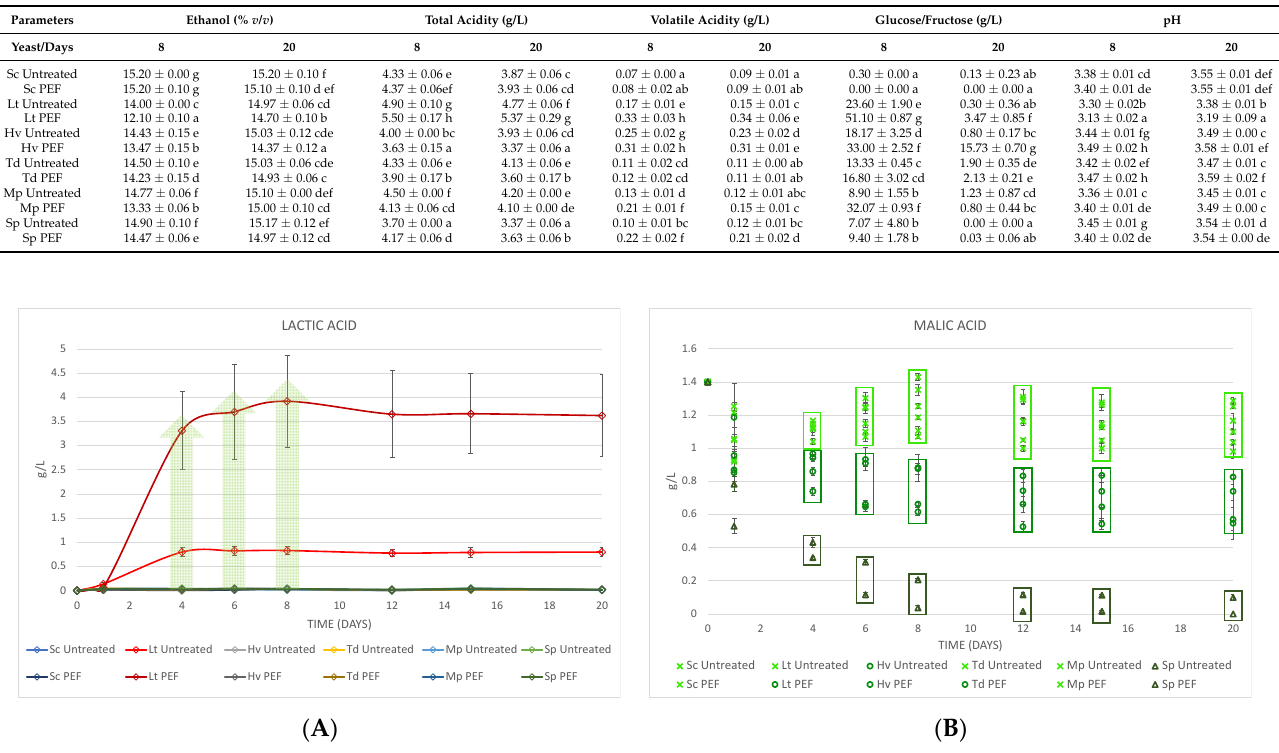
Figure 5. ( A ) Lactic acid produced in the fermentations. ( B ) Malic acid at the end of fermentation divided into three groups by amount of malic acid produced. Values are means ± sd ( n = 3).